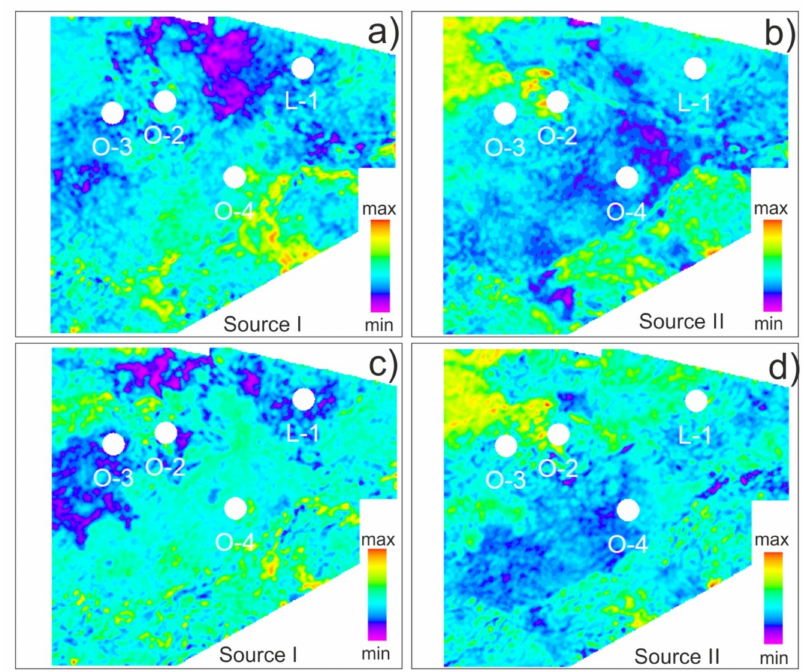
Figure 5. Maps of average values for BI elast ( a ) in Source I and ( b ) in Source II, and for BI min ( c ) in Source I and ( d ) in Source II. Red indicates the maximum value and purple indicates the minimum